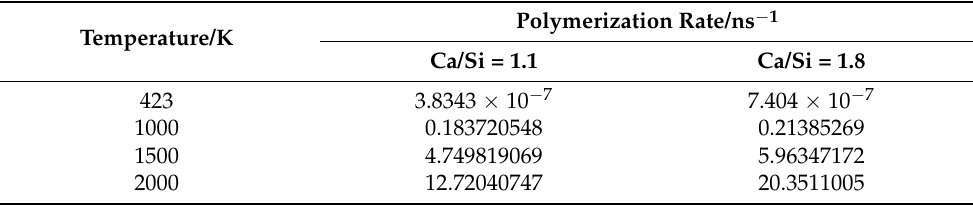
Table 3. Initial polymerization rate of C-S-H by different temperatures and C/S ratios.